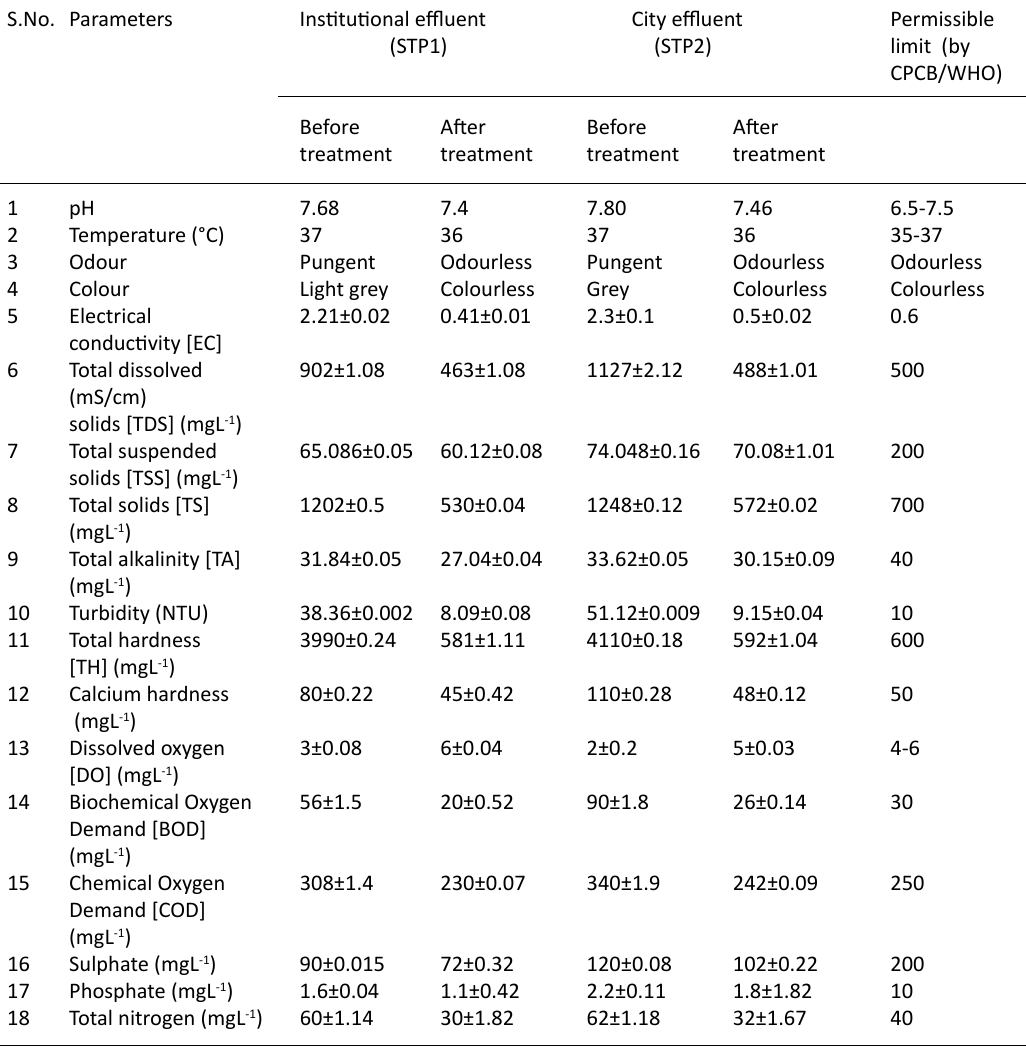
table 6. Physico-chemical characterization of the effluents after treatment in the bioreactor S.No.